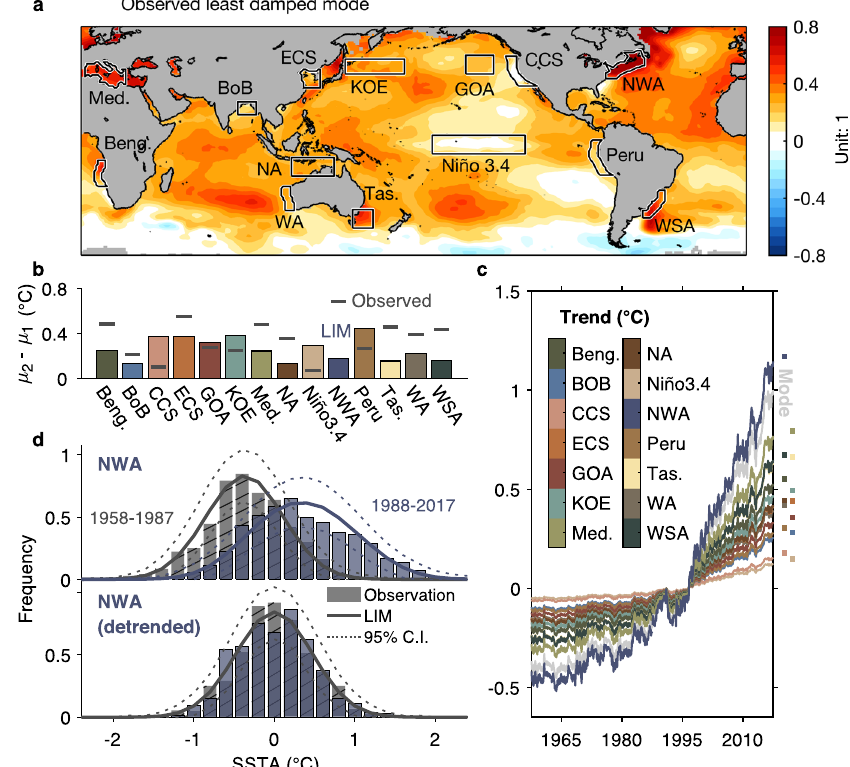
Fig. 2 | Sea Surface Temperature (SST) trends over the historical period. a Pattern of the trend mode (Unit: dimensionless) over 1958 – 2017 (see Methods). b Regional mean changes, calculated as differences between mean SST Anomaly (SSTA) during 1958 – 1987 ( μ 1 ) and 1988 – 2017 ( μ 2 ) at each targeted region. Hor- izontal lines are observed mean changes. Bars mark the edges of the 95% con- fi dence interval of mean changes, obtained from a 3000-member LIM ensemble. The LIM was constructed from detrended observations and reanalyses over the 1958 – 2017 period (the “ LIM5817 ” ensemble; see Methods). c Regional trend time